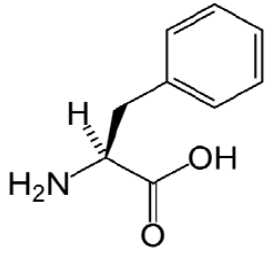
Figure 1. L-Phe Figure 1. L-Phe structure .